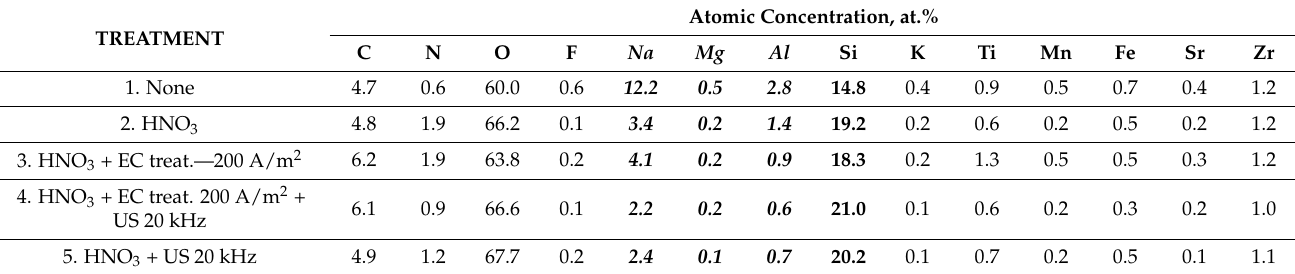
Table 9. XPS results of the eudialyte surface layer.